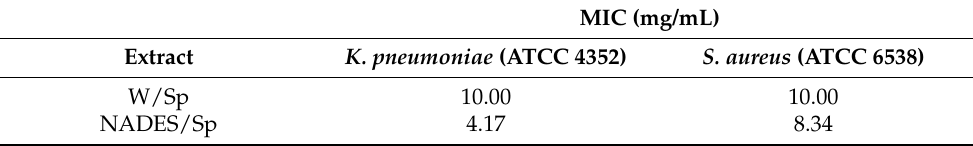
Table 2. Minimum inhibitory concentration (mg/mL) of Spirulina platensis